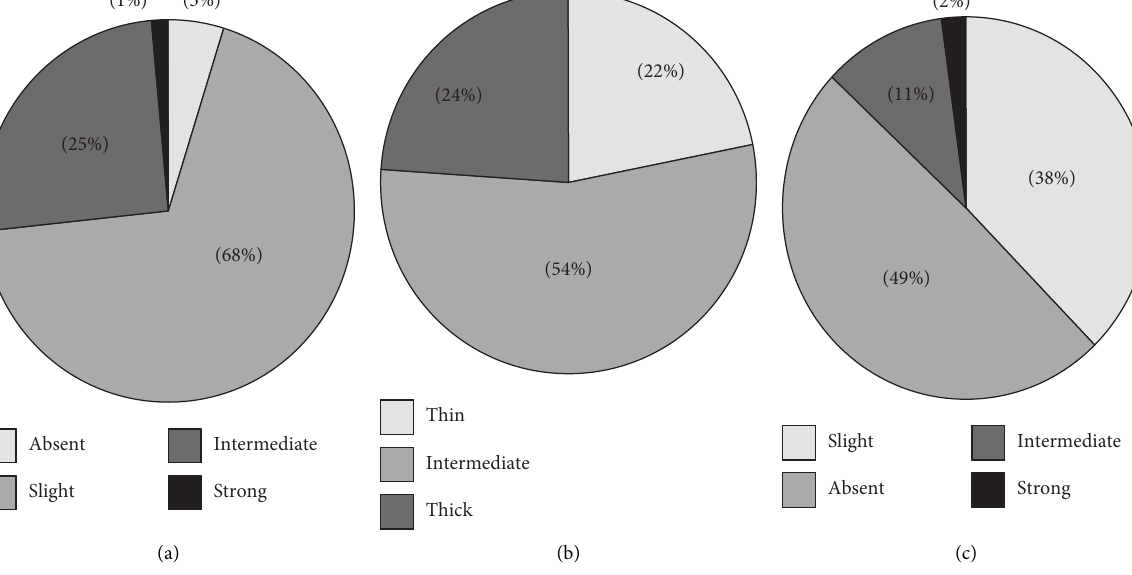
Figure 3: Morphological characteristics of the fruit of 146 ecotypes of fine-flavor native cocoa. (a) Fruit surface rugosity. (b) Fruit wall thickness. (c) Basal